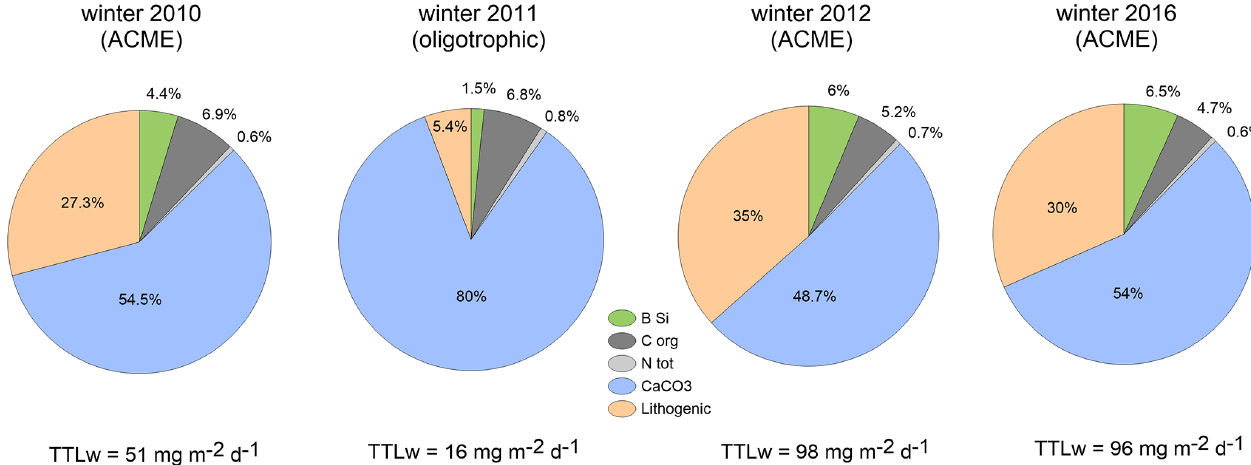
Figure 6. Flux compositions during winter (% of total winter mass flux, TTL w ) derived from the upper traps during the low-oxygen ACME of 2010 (Fischer et al., 2016), the low-flux (oligotrophic) conditions during winter 2011 (with low lithogenic and high carbonate contents), and the following ACMEs in winter 2012 and winter 2016 (high and almost equal to total fluxes and composition). Lithogenic components constitute approx. one-third of the total flux, except during oligotrophic conditions during winter